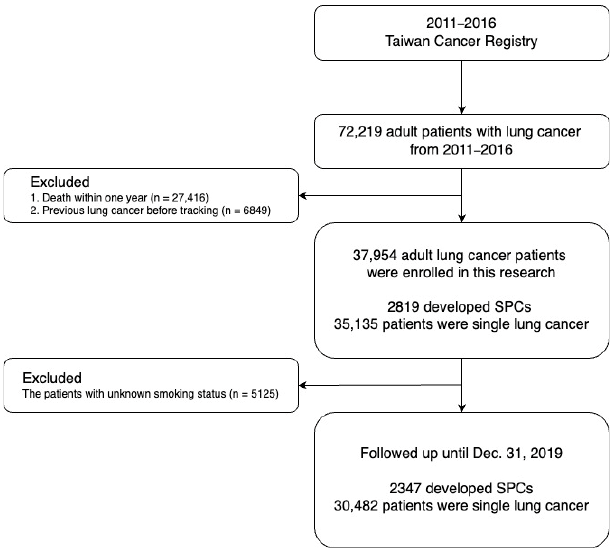
Figure 1. The study flowchart. SPCs — second primary